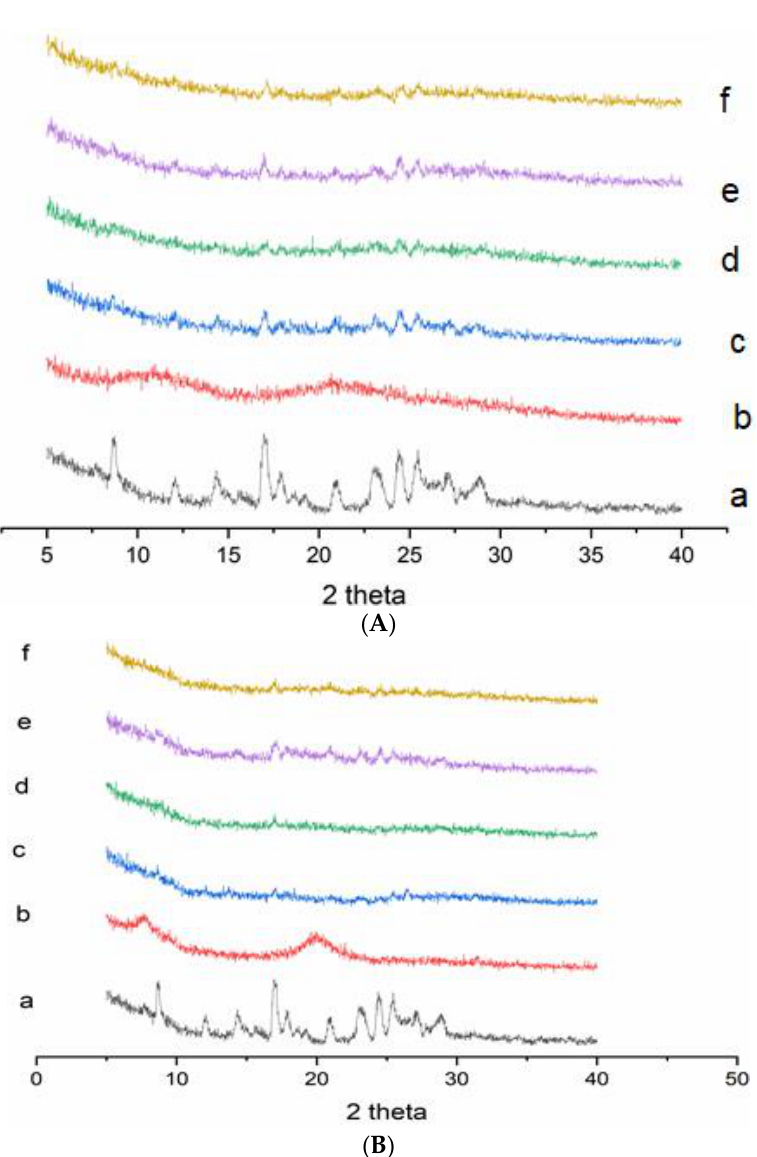
Figure 6. ( A ). Diffractograms of (a) pure curcumin, (b) HPMC E5, (c) CUR:HPMC E5 1:2 KN,